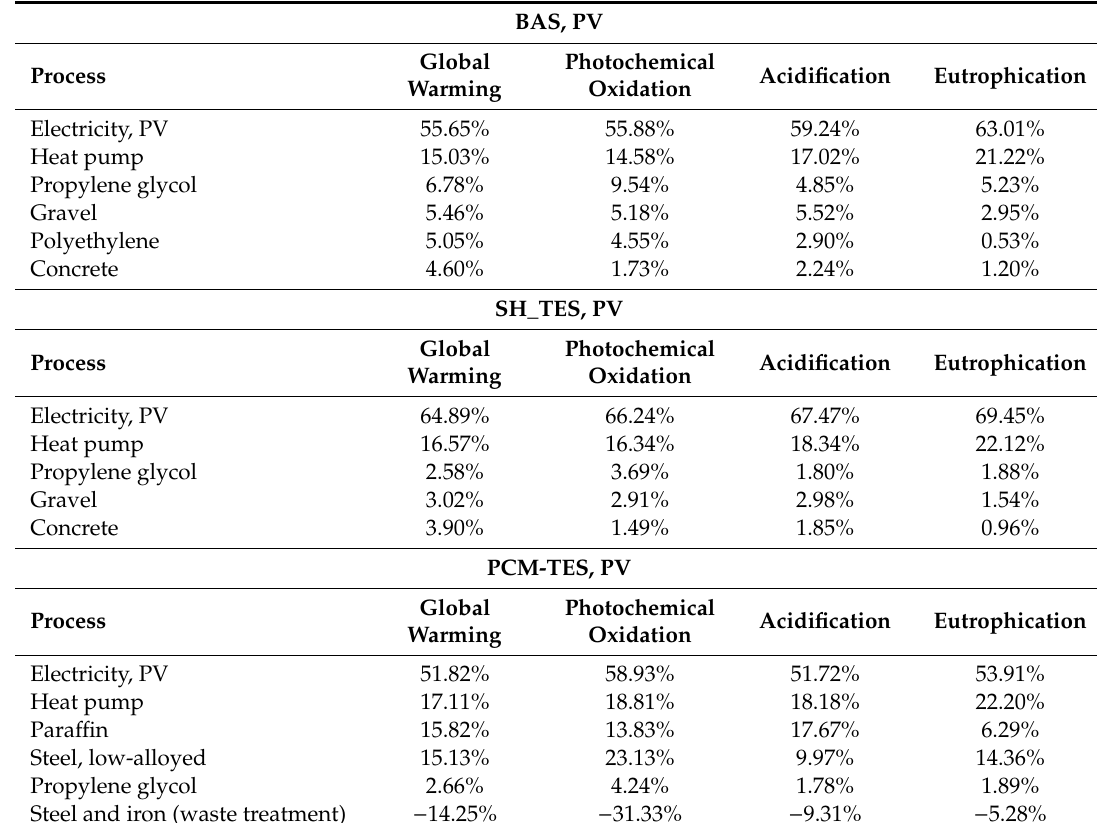
Table 7. Incidence of highest impact processes (electricity from